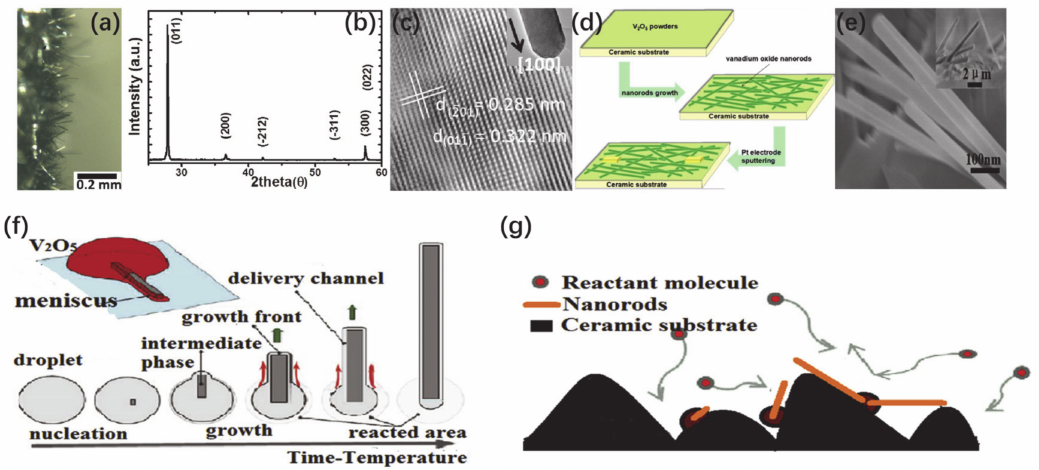
Figure 11. ( a ) Optical image of the side view of free standing VO 2 NWs. ( b ) XRD pattern of the products. ( c ) HRTEM image of a VO 2 NW; the inset shows the low-magnification TEM image of the growth front. Reproduced from [83], with permission from AIP Publishing, 2012. ( d ) Schematic diagram of the preparation of VO 2 NRs. ( e ) SEM image of VO 2 NRs, and the inset is the cross-sectional view. ( f ) The schematic diagram of the growth mechanism of free-standing VO 2 NRs. ( g ) Nucleation and evolution of nanostructures in precursor droplets. Reproduced from [84], with permission from Elsevier,